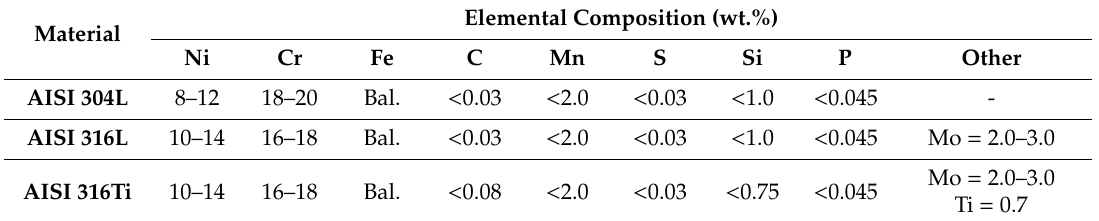
Table 3. Composition of stainless steels used in the construction of Model II MH-DCFC (wt.%). Elemental Composition Material